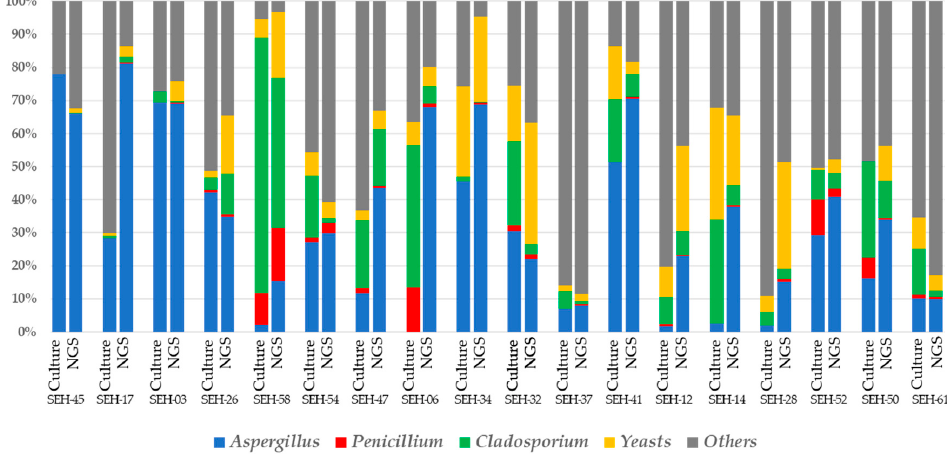
Figure 4. Comparisons of fungal occupancy rates between the next-generation sequencing (NGS) and culture methods. The bars are arranged from left to right by increasing total fungal counts / 1 g house dust. Table2. Spearman’srankcorrelationcoe ffi cientbetweentheNGSandculturemethodsandacomparison of the two groups of house dust samples as divided by whether the total fungal counts / 1 g house dust were above or below 10 6 colony-forming units